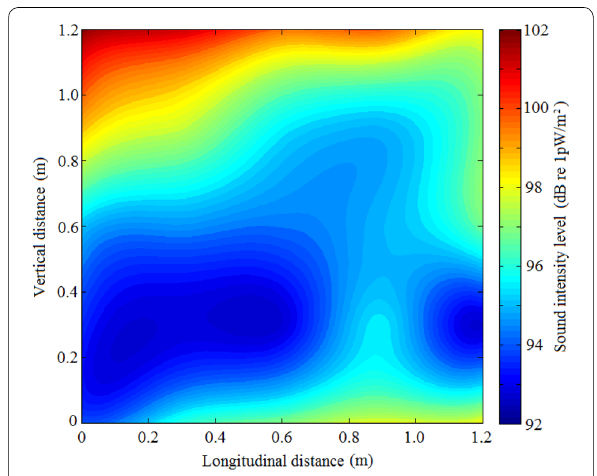
Figure 16 Sound intensity level of the interior sidewall (100– 5000